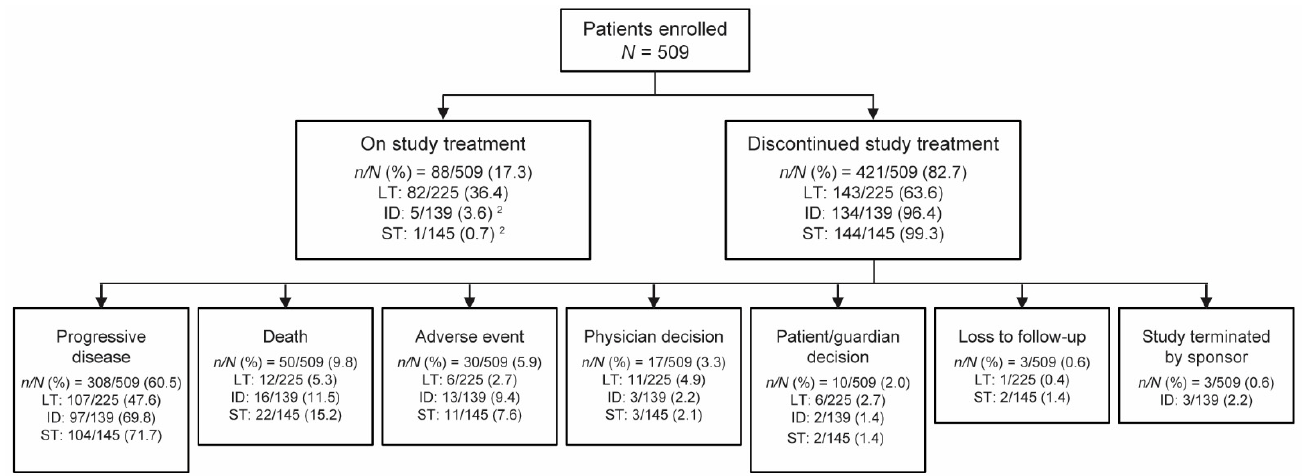
Figure 1. Patient disposition 1 . 1 Intention-to-treat population. 2 Patients who were undergoing treatment at the time of site initiation for <12 months were (erroneously) enrolled in the study. ID, intermediate duration of benefit; LT, long-term duration of benefit; ST, short-term duration of benefit.